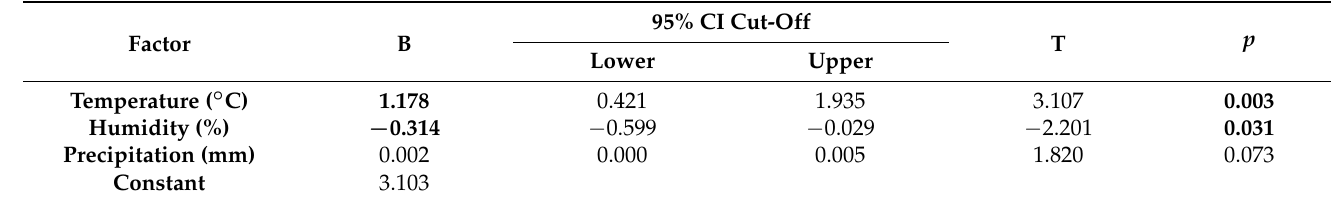
Table 5. Association between the number of cases of leishmaniosis from 1945 to 2014 in central parts of Montenegro and average yearly values of meteorological factors (temperature, humidity, and precipitation).